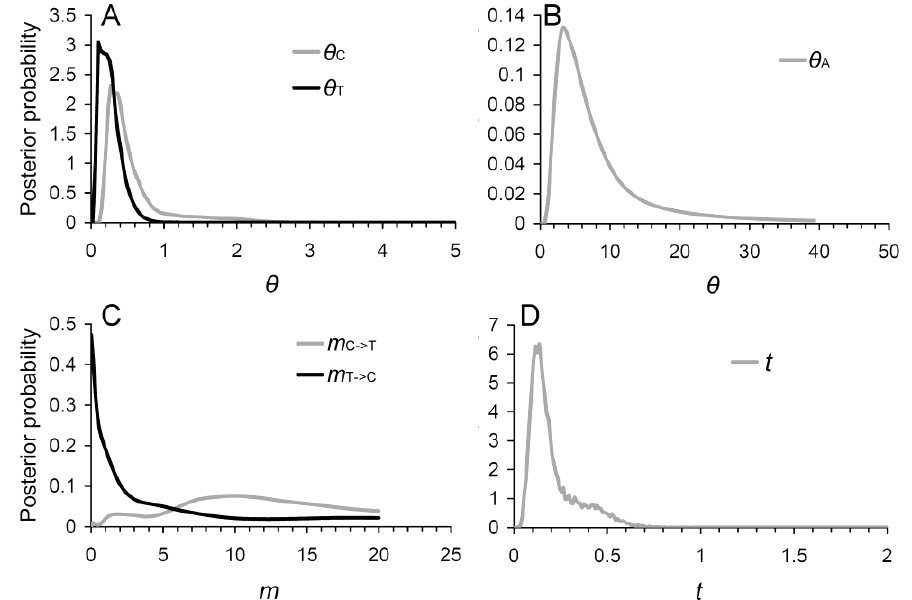
Figure 5. Marginal posterior probability density distribution of ( A ) the current effective population size of the cultivar accession and the Taiwan accession; ( B ) the ancestral population size; ( C ) migration rates of the cultivar accession and the Taiwan accession; and ( D ) divergence time of these two accessions, each scaled by the geometric mean of the mutation rates of all loci